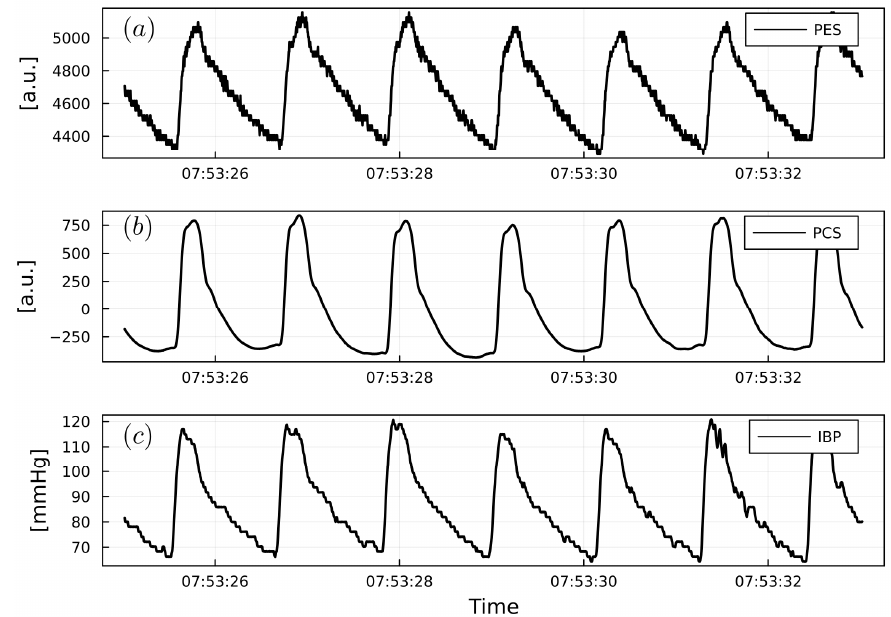
Figure 5. ( a ) Example of PW PES . ( b ) Example of PW PCS . ( c ) Example of PW IBP from a cardiac surgery patient. PW PES and PW PCS are reported as arbitrary units (a.u.). PW IBP is reported as mmHg.